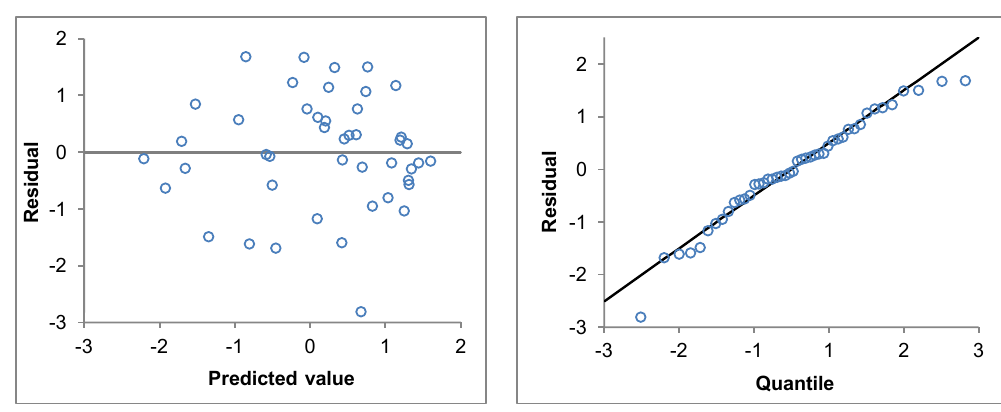
Scatter plot and normality plot of the residual of the HT data set’s linear-regression